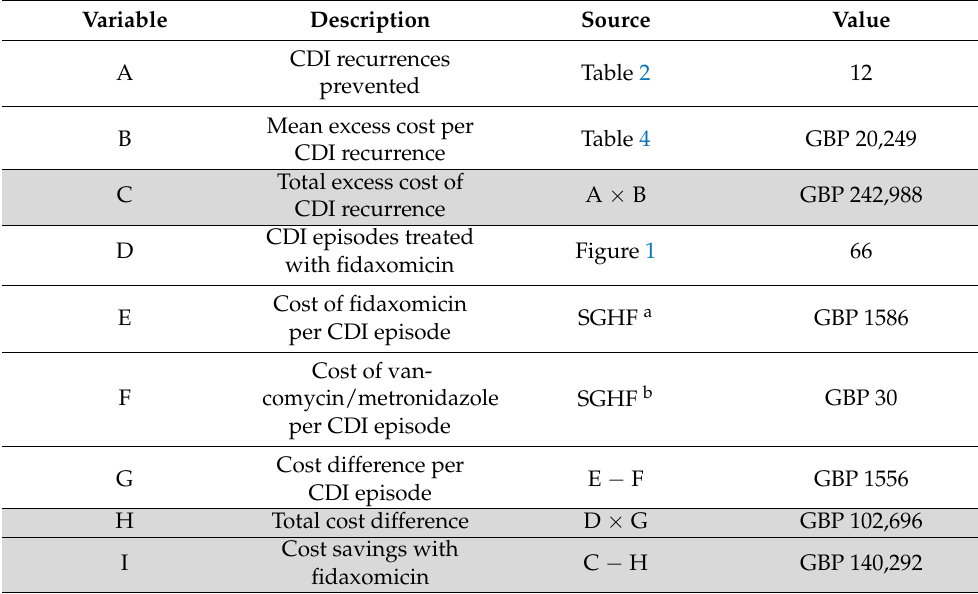
Table 5. Estimated cost savings with fidaxomicin vs. vancomycin or